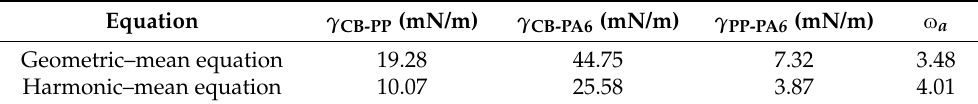
Table 2. The calculated interfacial tension and wetting coefficient at 230 ◦ C. Equation Harmonic–mean equation Due to the synergistic effect of the fine connection between PA6 microfibrils and the selective accumulation of CB at the interface, a 3D entangled conductive structure consisting of CB-coated PA6 microfibrils is formed in the CB/PA6/PP MFCs. The formation diagram is shown in Figure 4. CB and PP are firstly mixed, and the CB/PP masterbatch is prepared (Figure 4a). Then, PA6 is added to the CB/PP masterbatch, and CB/PA6/PP blends are prepared. During this process, CB particles migrate from PP to PA6, and accumulate at the interface region (Figure 4b). The CB/PA6/PP blends are extruded through a slit die. Under the combined effect of the elongational and shear flow, CB-coated PA6 microfibrils are in situ generated in the PP matrix and aligned with the stretch direction (Figure 4c). During the following compression mold, local flow and diffusion of the melted PP make CB-coated PA6 microfibrils interconnect with each other and form a 3D entangled conductive structure (Figure 4d).